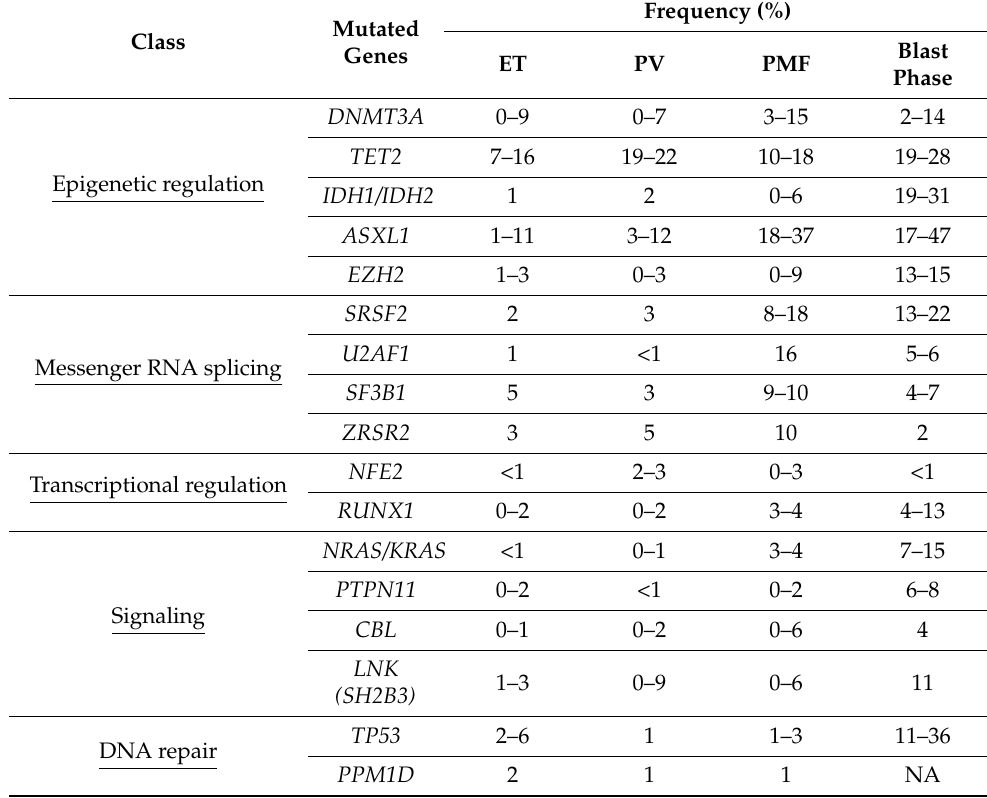
Table 1. Frequencies of additional somatic mutations in